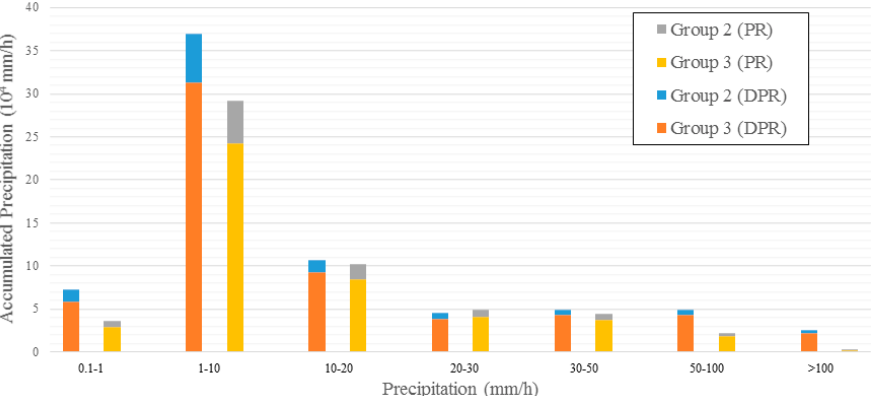
Figure 8. Histograms of accumulated precipitation based on global coincident events between DPR and PR in Group 2 and 3. and PR in Group 2 and